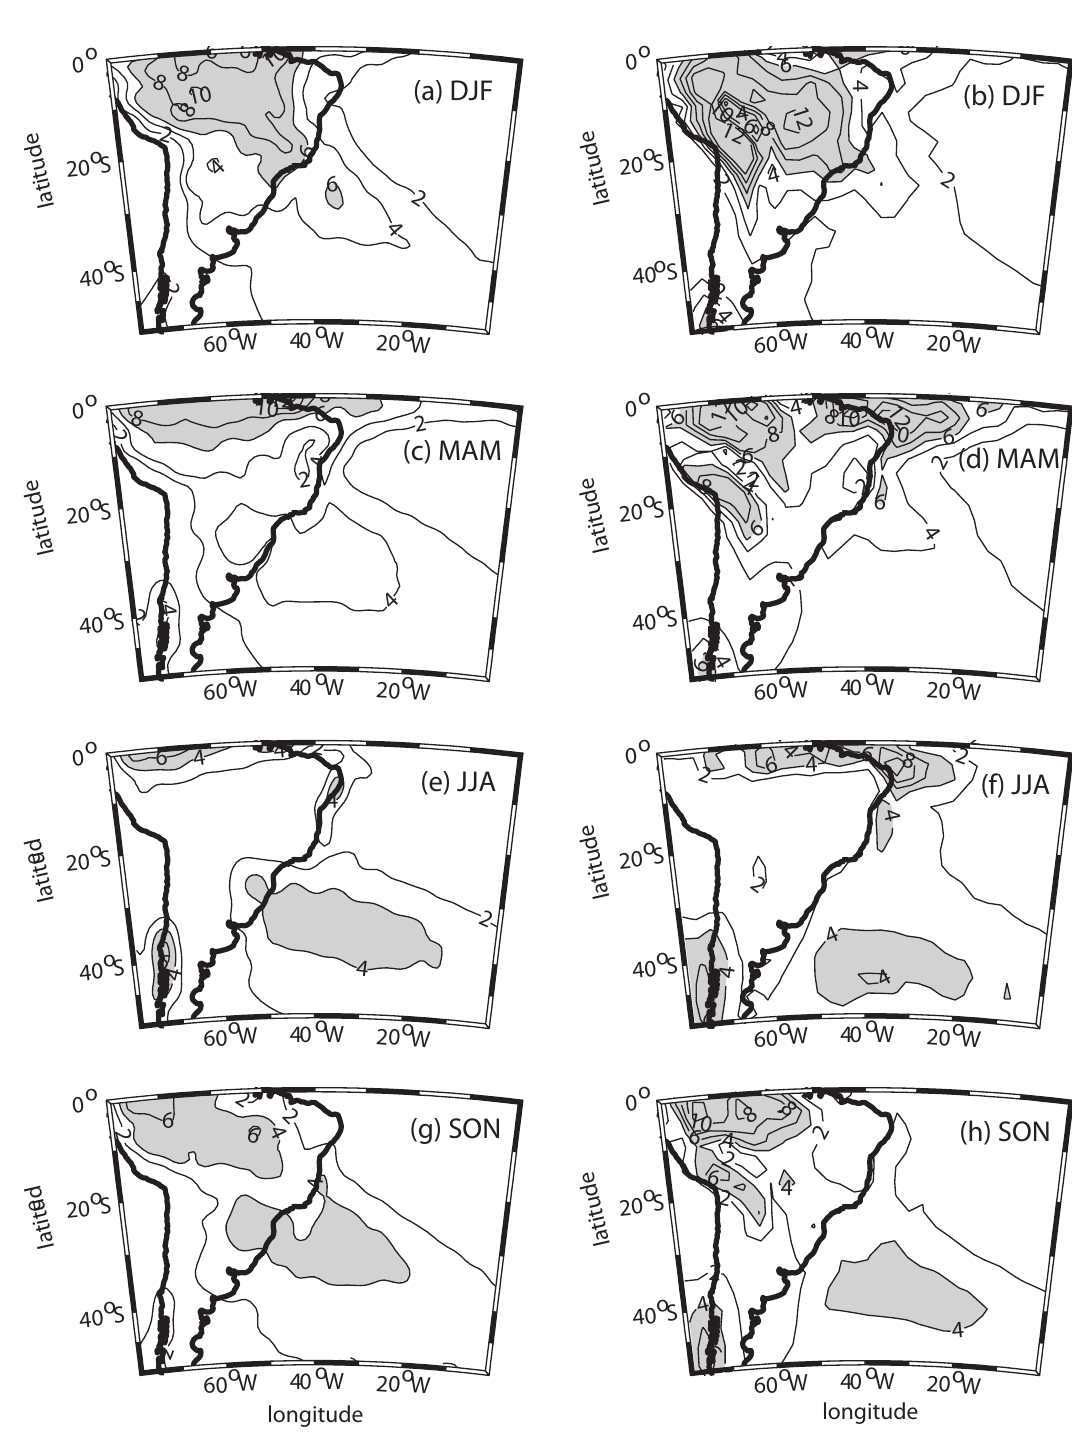
Fig. 1. Seasonal mean precipitation comparison: Xie and Arkin (1997) in the left column and EXP1 ensemble mean in the right column. (a–b) DJF, (c–d) MAM, (e–f) JJA and (g–h) SON. Contour interval is 2mmday − 1 . Rainfall greater than 6mmday − 1 in DJF and MAM and 4mmday − 1 in JJA and SON are shaded to facilitate the